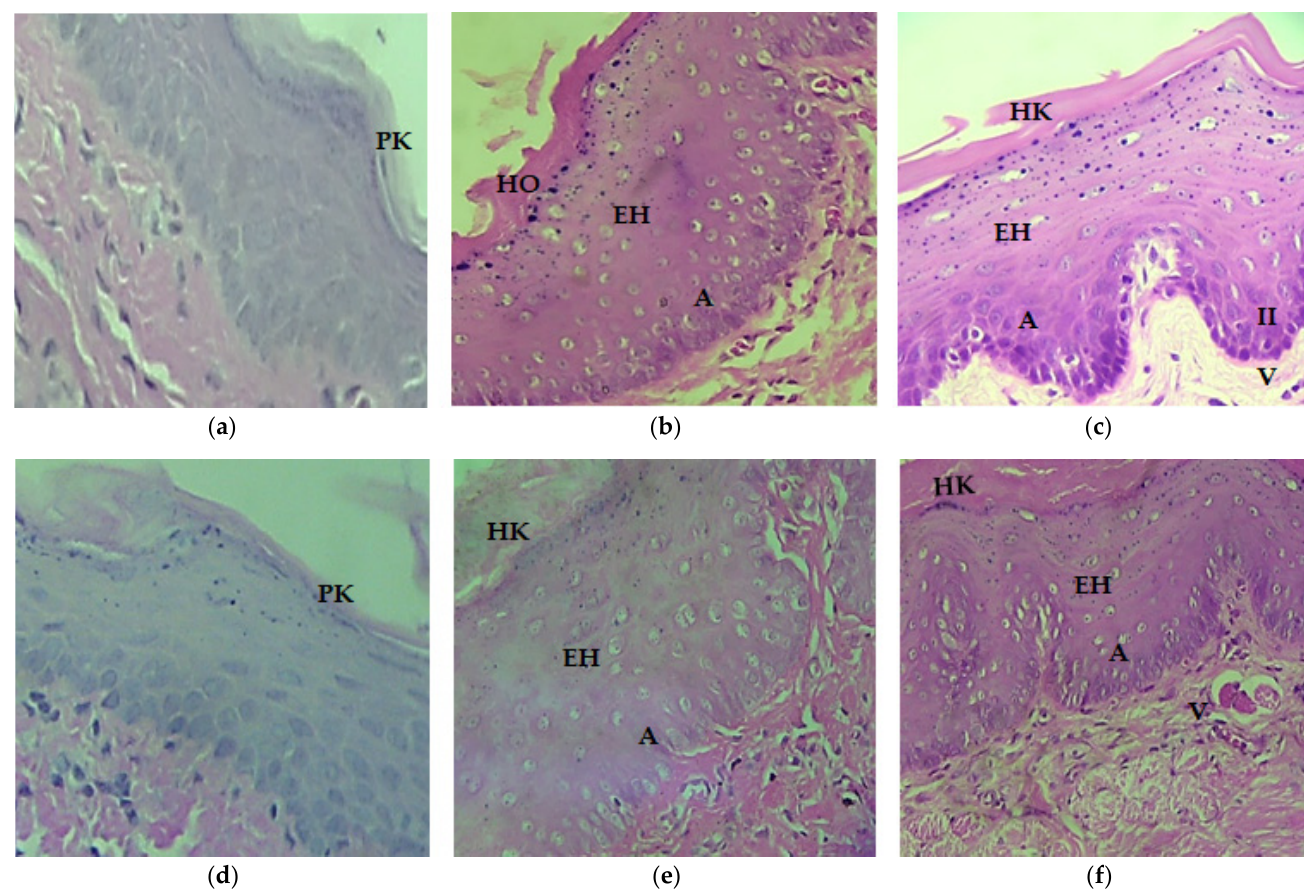
Figure 1. Histological modifications of the cheek mucosa tissue with hematoxylin–eosin (H&E) staining (40×). ( a ) Female control group, ( b ) female group 40% alcohol consumption, ( c ) female group 5% alcohol consumption, ( d ) male control group, ( e ) male group 40% alcohol consumption, and ( f ) group of males consuming 5% alcohol. PK, parakeratinized; K, keratinized; HO, hyperor- thokeratinized; HK, hyperkeratinized; EH, epithelial hyperplasia; A, acanthosis; II, inflammatory infiltrate; V, blood vessels.